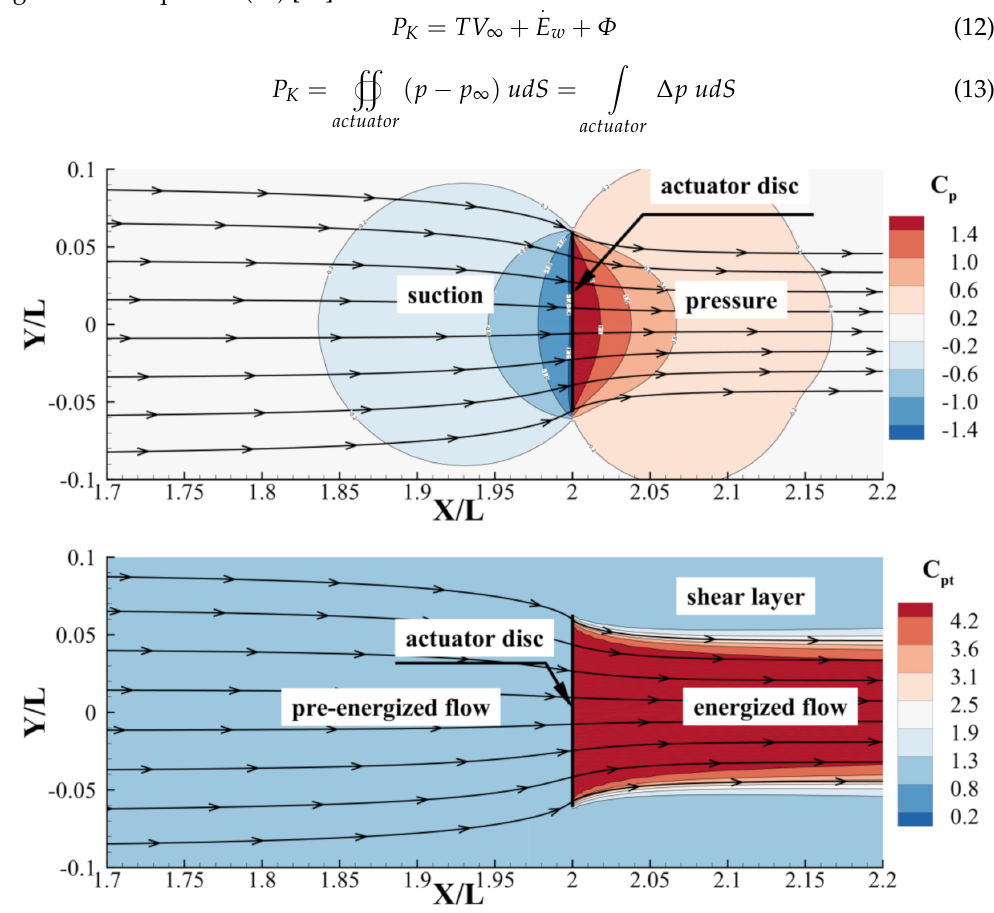
Figure 7. Contours of pressure coefficient ( top ) and the coefficient of total pressure ( bottom ) around an actuator disc, including a mirrored flow field